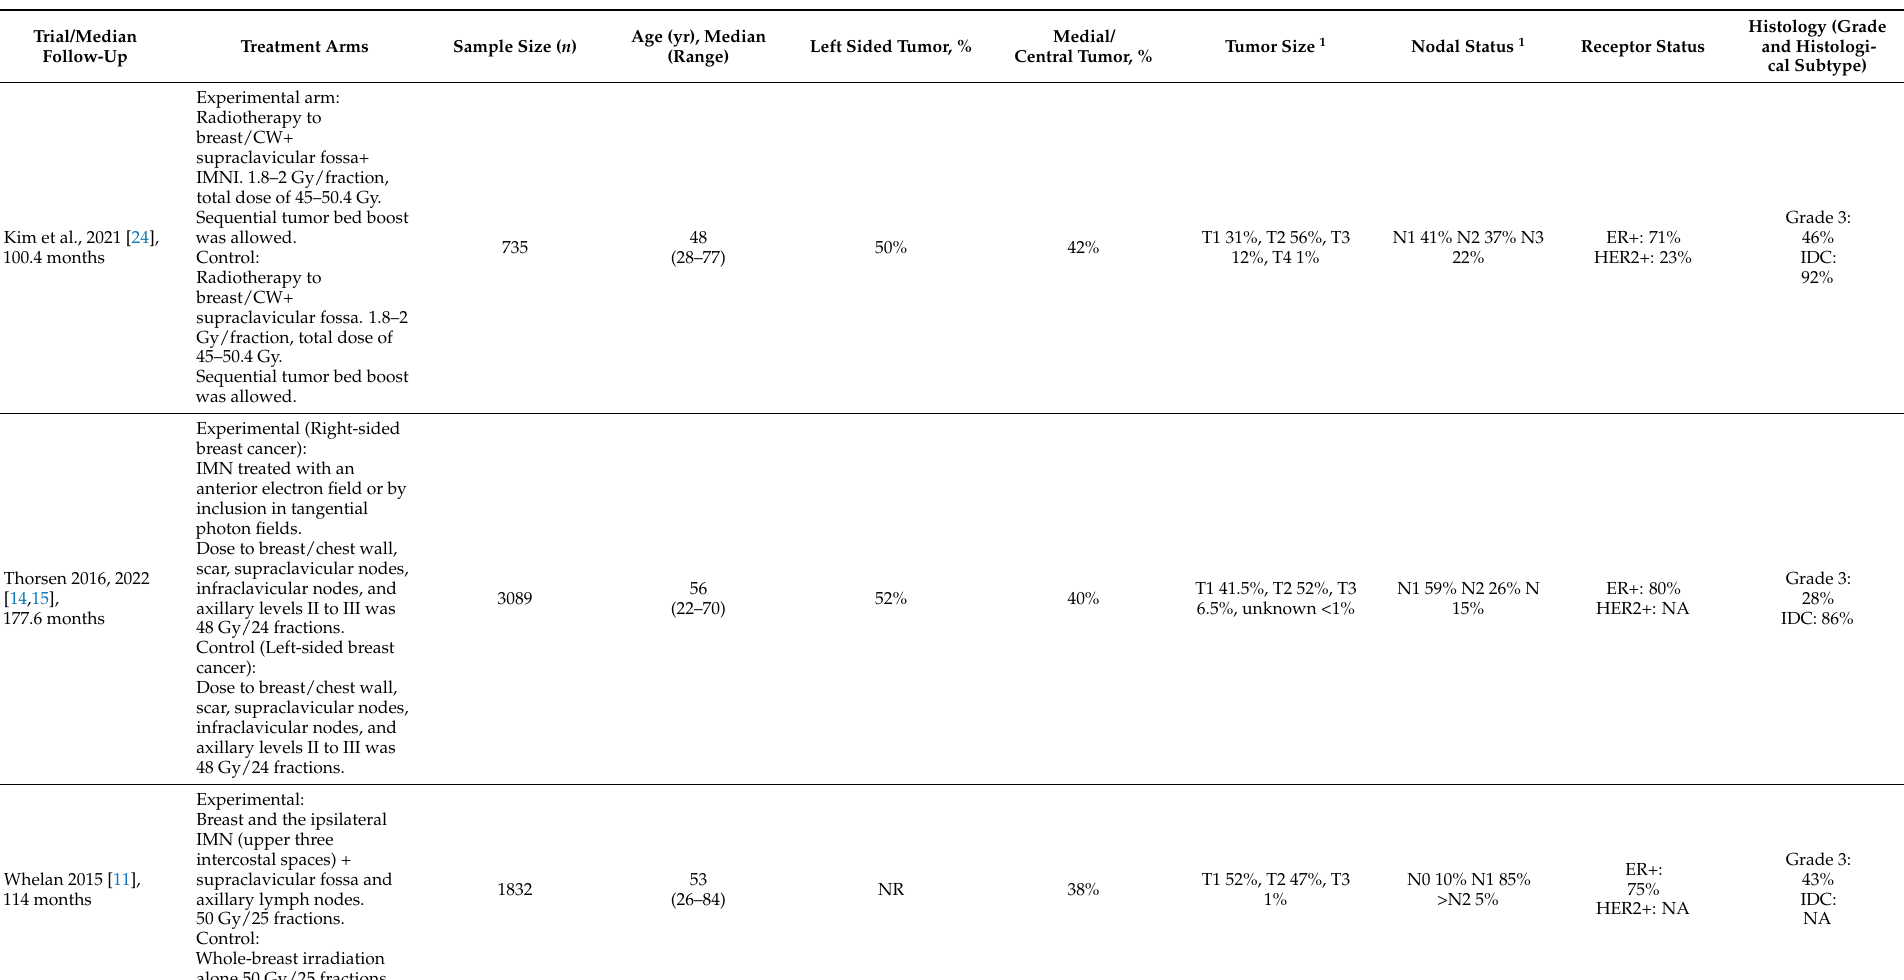
Table 1. The characteristics of the included